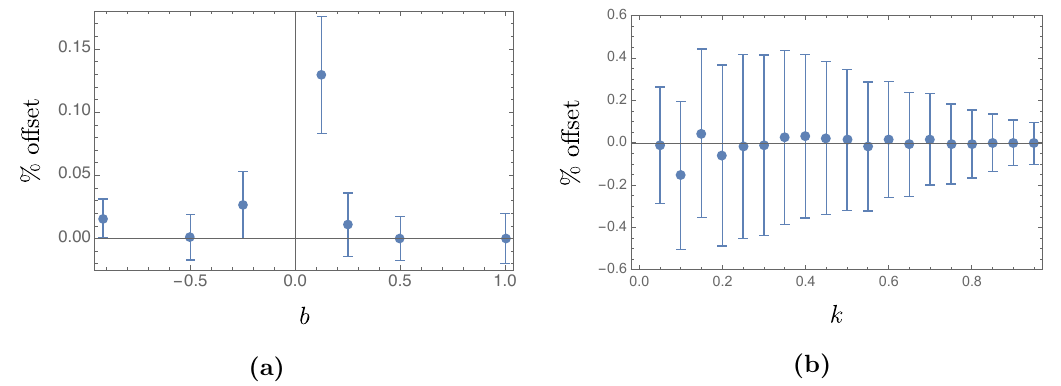
Figure 5. The o(cid:11)set between our results for (a) di(cid:11)erent values of b with (cid:18) = 0 and (b) di(cid:11)erent values of the recoil parameter k with b = 0 and the known results from the literature is shown.